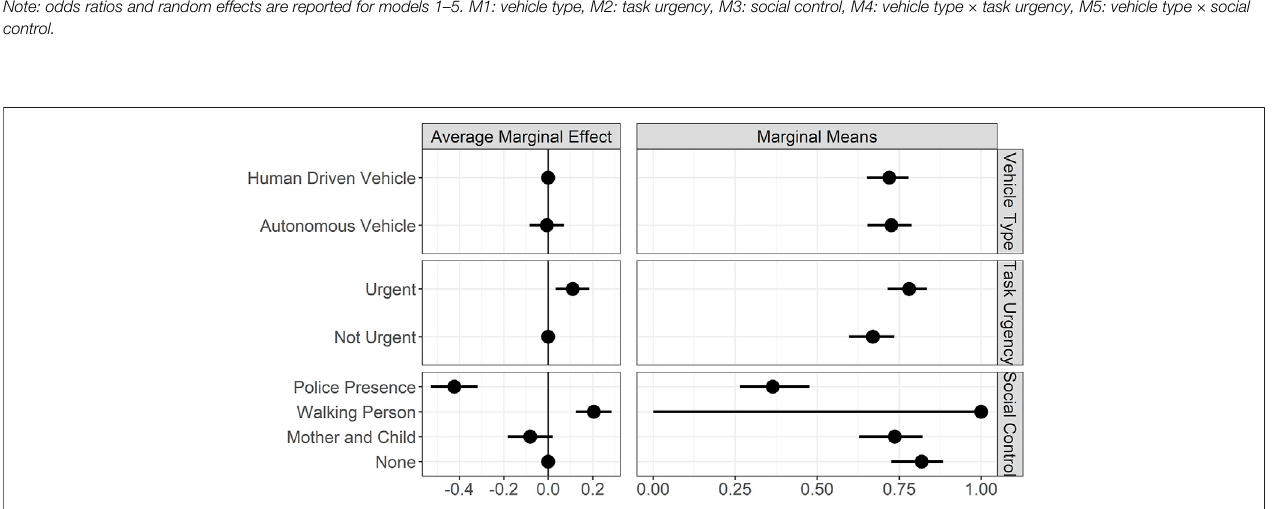
Frontiers in Robotics and AI |